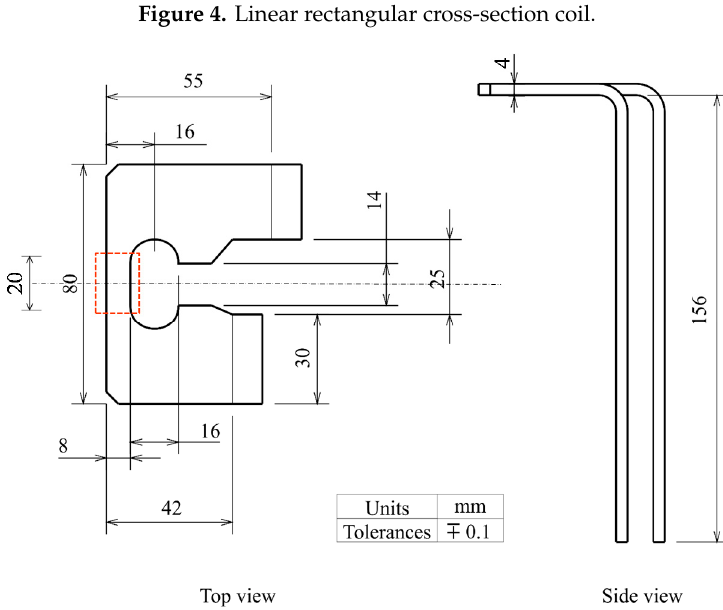
Figure 5. O-shape coil dimensions